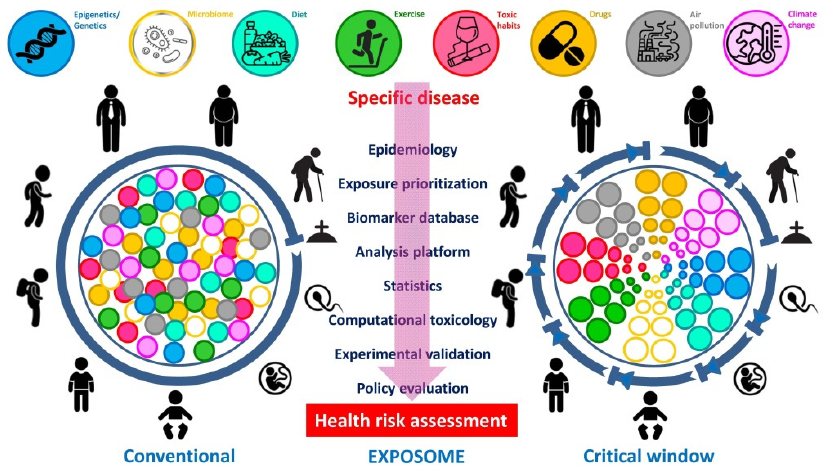
Figure 2. Conventional versus critical window “exposome” views in assessment of health risk in humans. The comprehensive portrait of an individual’s “exposome” evolves throughout the lifetime with the possibility of prioritized exposure factors, during specific time-points or critical windows as opposed to a standard, random or linear exposure. The diagram emphasizes the relevance of measurements at different time-points (modified from Fang et al. [131]).